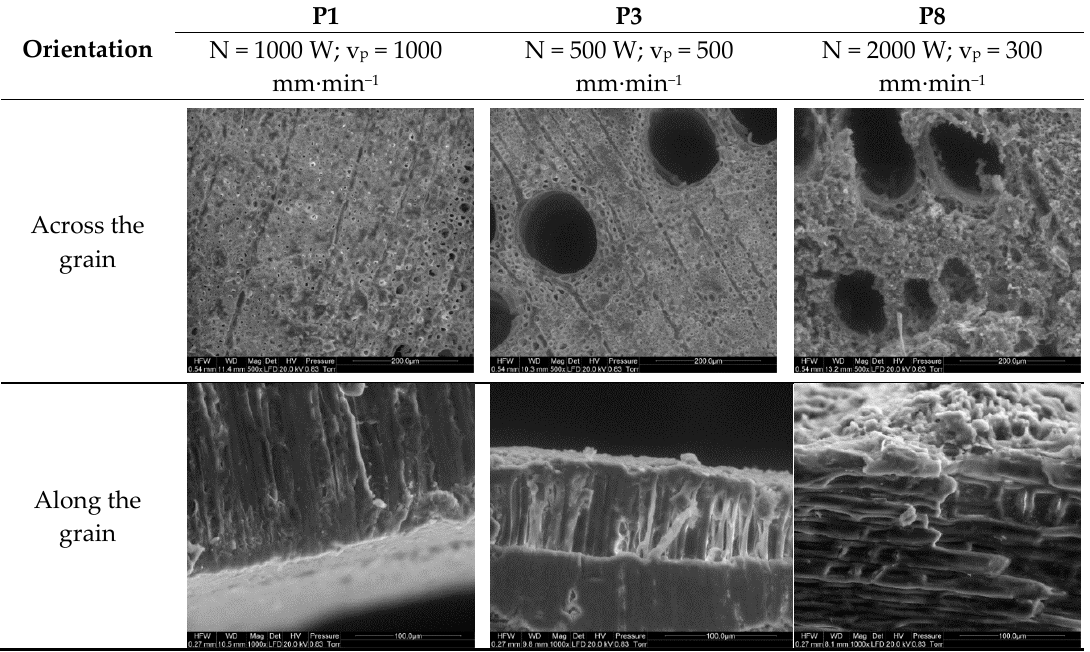
Figure 7. Surface structures of oak wood cut with a laser beam across and along the grain (trials P1, P3, and P8). and